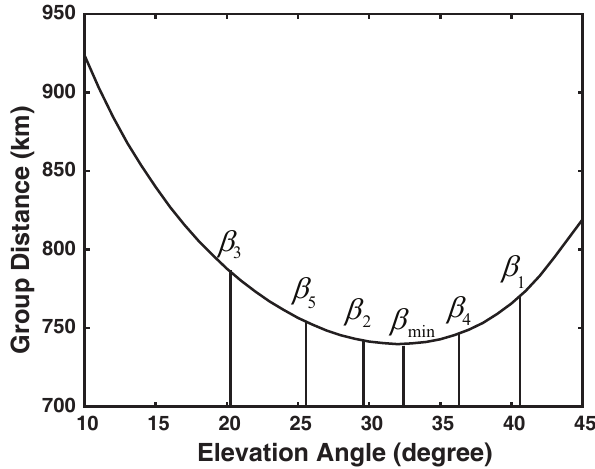
Fig. 1. Variation of group distance with elevation angle for a certain transmitted frequency, where β 1 , β 2 , β 3 , β 4 , β 5 , means different elevation angle and β min is the elevation angle corresponding to minimum group